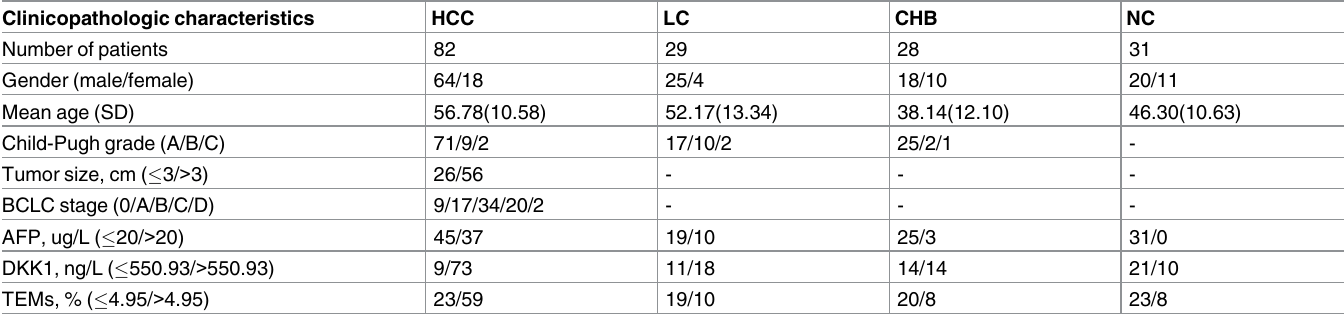
Table 1. Clinical characteristics of the study participants. Clinicopathologic